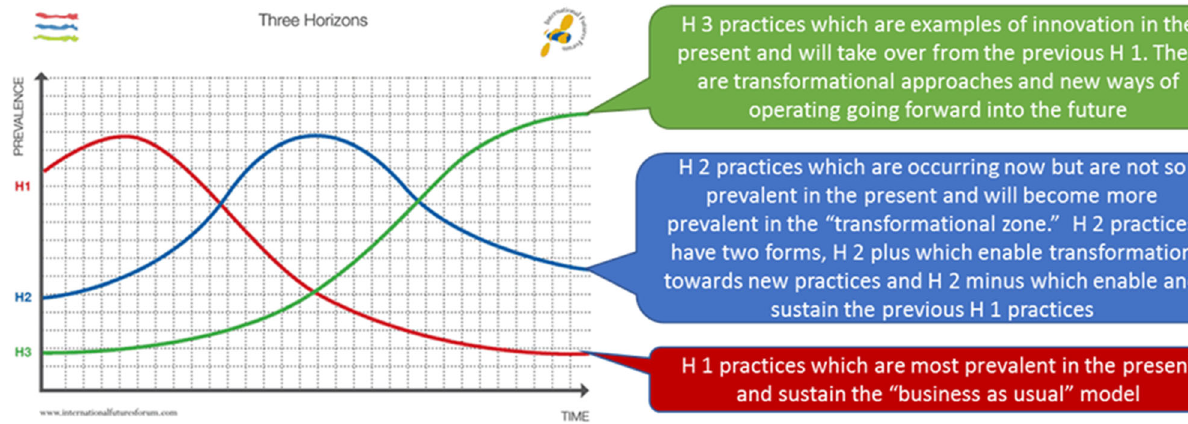
Fig. 2 Graphic representation of the Three Horizons Approach. Source : International Futures Forum